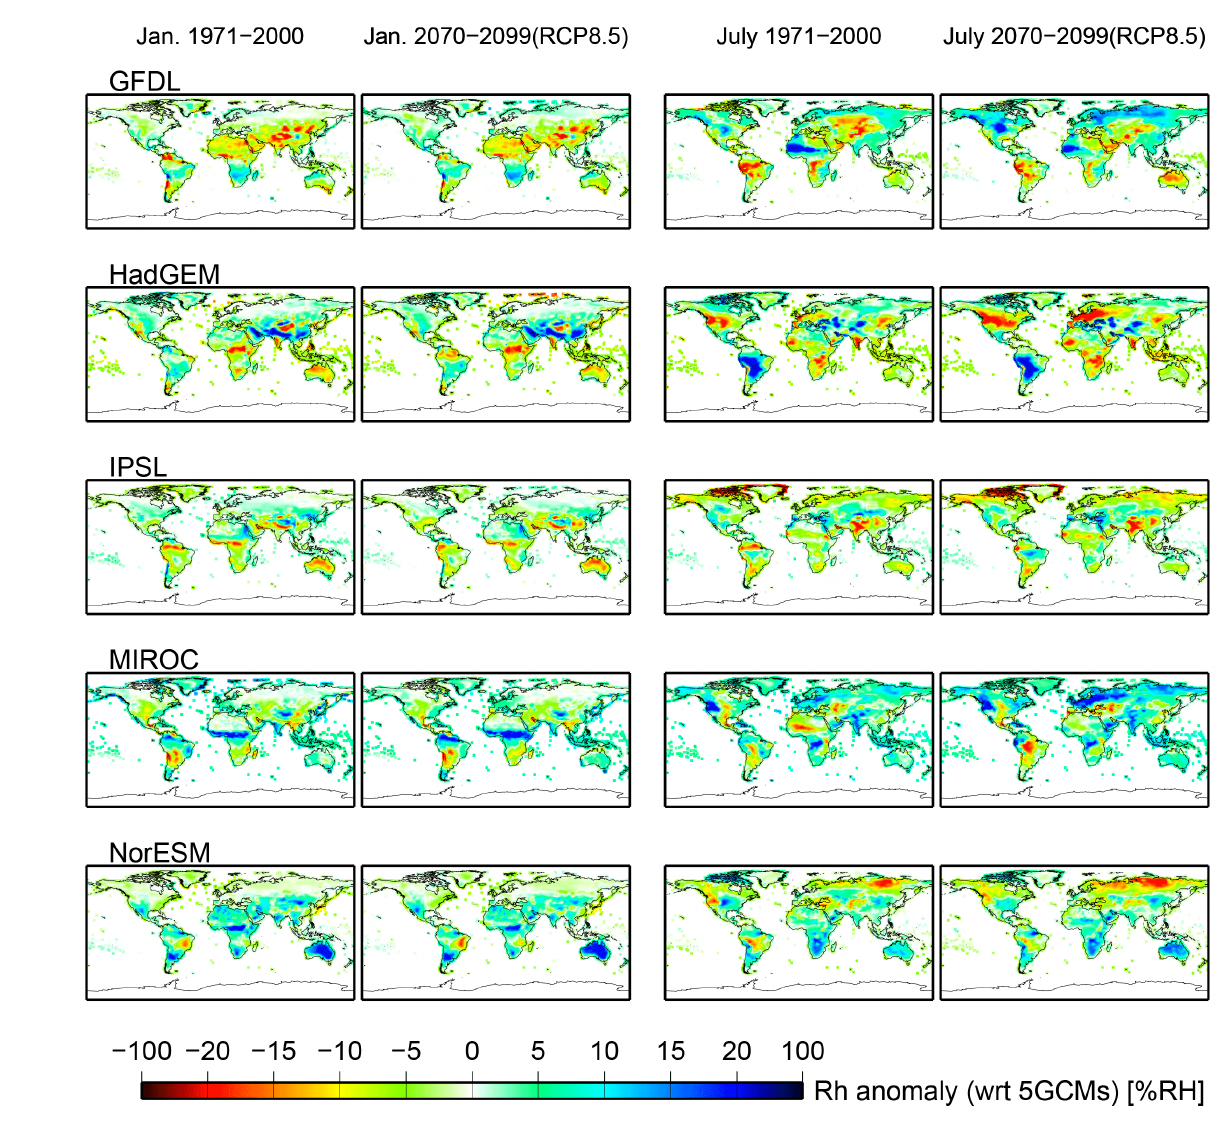
Figure 10. Geographical distribution of the monthly anomaly of the relative humidity with respect to the ensemble mean of five GCMs for January (left two columns) and July (right two columns). Each pair of adjoining panels shows results for the present (1971–2000) and future (2070–2099, RCP8.5) periods, respectively. Table 5a. Results of the reference and sensitivity experiments with artificial biases of ± 5%RH – irrigation water demand (IWD). The values in parentheses are changes (%) relative to the original